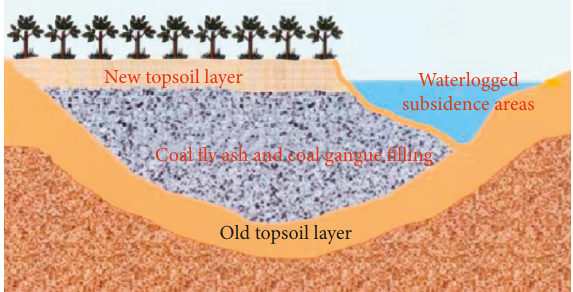
Figure 2: Diagram of filling the reclamation area of mining subsidence